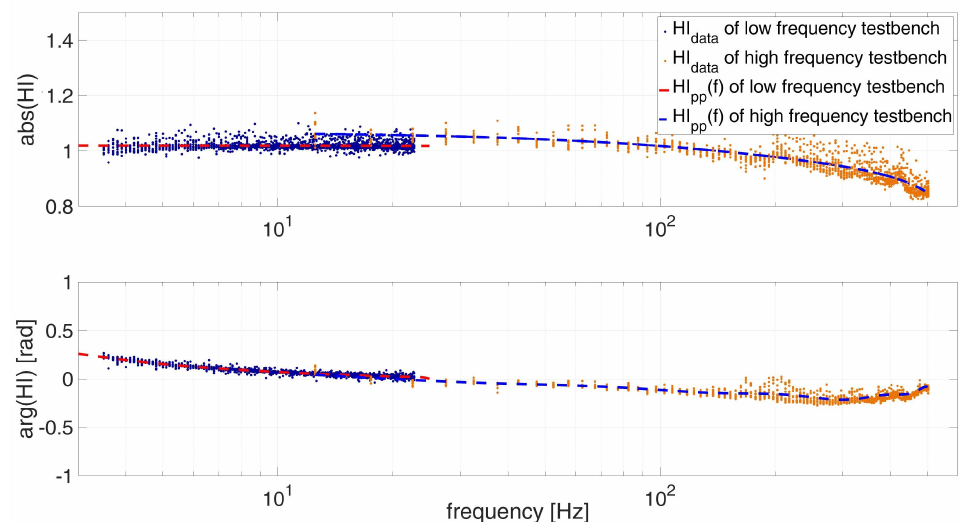
Figure 6. Measurement systems FRF HI pp over frequency of both test